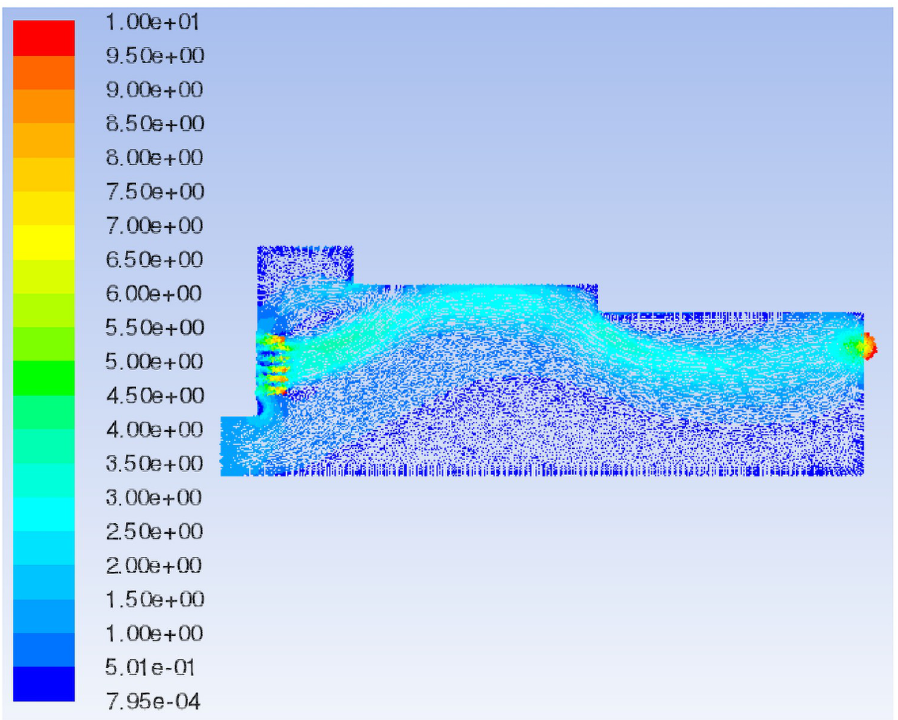
Fig 12. Flow field velocity vector of the increased air volume